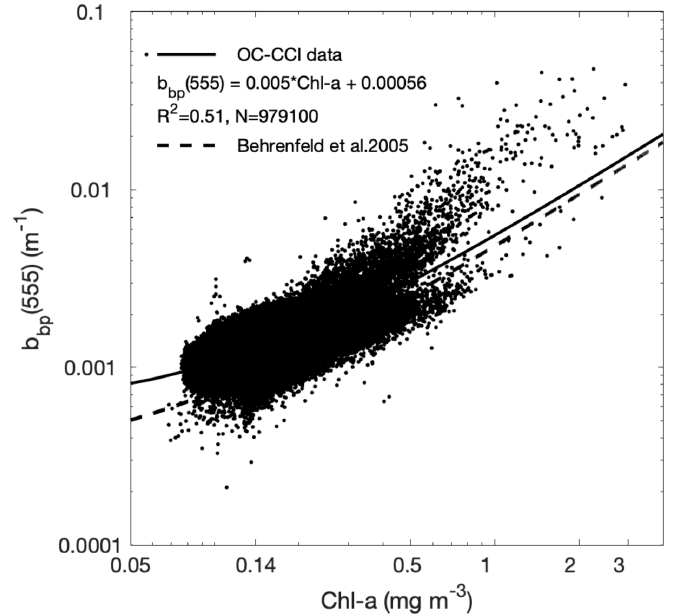
Figure 2. Particle backscattering at 555 nm ( b bp (555), m − 1 ) is likely a function of chlorophyll a concentration (Chl-a, mg m − 3 ) for monthly mean climatology of satellite data (September 1997 to December 2019) of the South China Sea. The solid black line represents a linear fit to (Ocean Colour Climate Change Initiative) OC-CCI data. For comparisons, a similar relationship obtained from global satellite dataset [16] (black dash line) is shown. We applied a spectral dependence of λ − 1.03 to transfer the curve reported at 440–555 nm consistent with the slope used by the GSM model [51] .